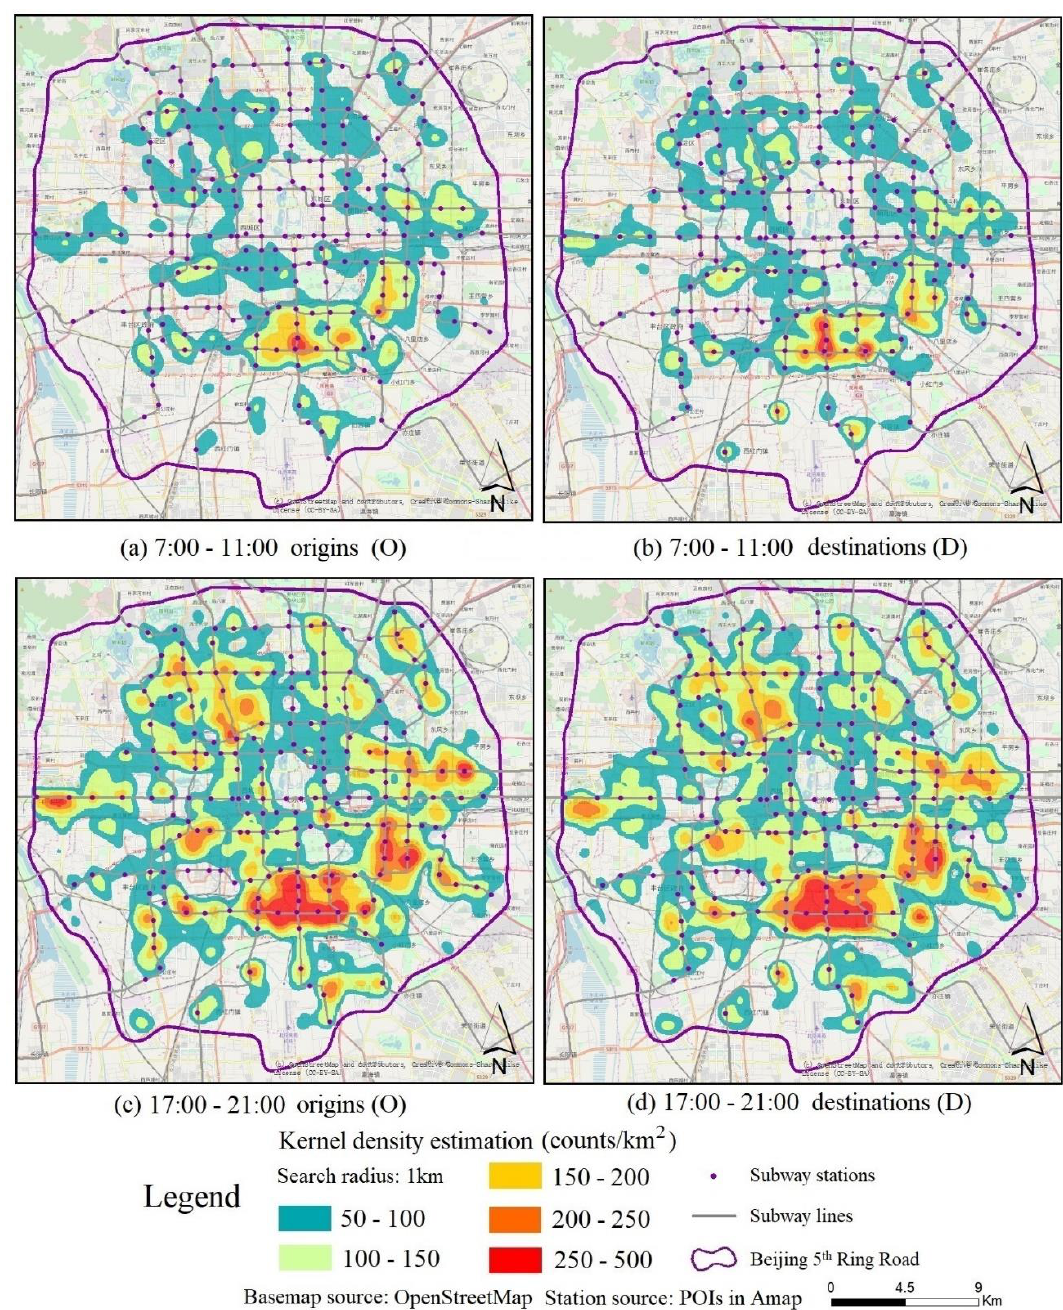
Figure 6. The shared bicycle hotspots on the weekends.